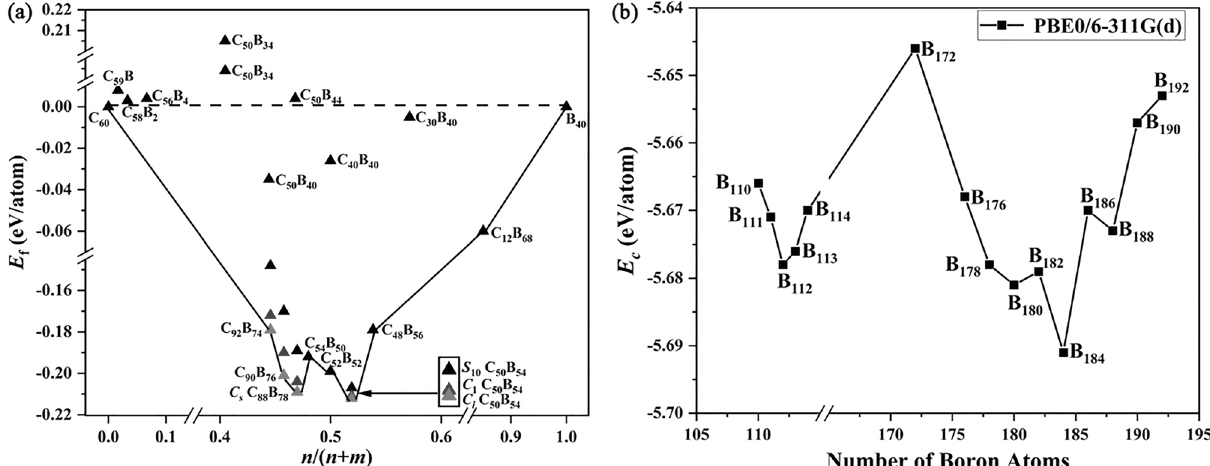
Figure 2. ( a ) Calculated formation energy per atom ( E f , eV atom −1 ) as a function of the n /( m + n ) ratio in the optimized boron–carbon clusters C m B n and ( b ) cohesive energy per atom ( E c , eV atom −1 ) of the optimized core– shell boron clusters B n ( n = 110–192) as a function of the cluster size ( n ) at